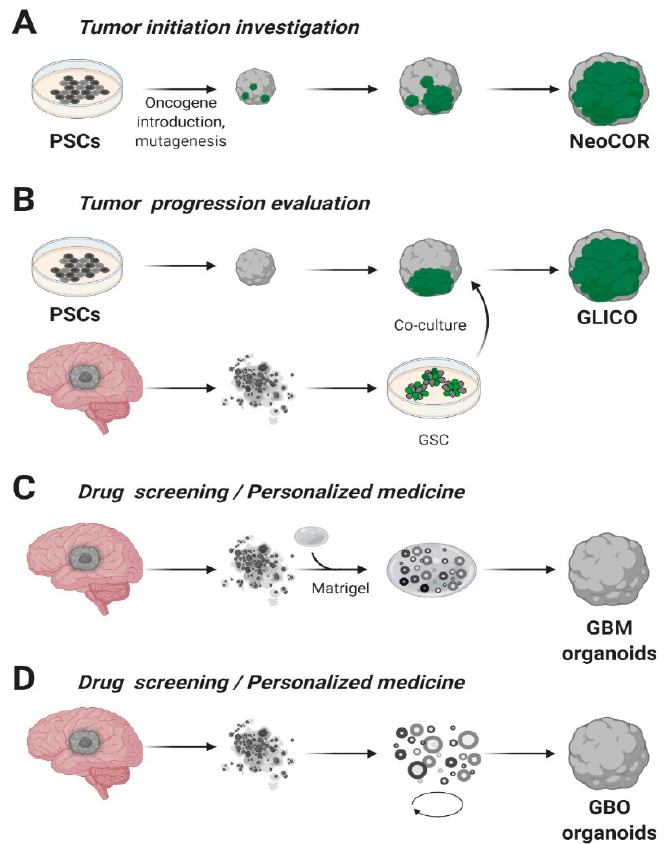
Figure 2. Glioblastoma organoids. ( A ) Cerebral organoids, derived from pluripotent stem cells (PSCs) or embryonic stem (ES) cells, can be genetically engineered introducing tumor-promoting mutations or oncogenes and green fluorescent protein (GFP) to visualize tumor growth. NeoCOR, neoplastic cerebral organoids [46,77]. ( B ) Glioblastoma stem cells (GSCs) marked with GFP have been co-cultured with cerebral organoids to obtain glioma cerebral organoids (GLICO) [77,79]. Patient-derived Glioblastoma (GBM) specimens have been embedded in Matrigel ( C ) [75] or cultured in Matrigel- and serum-free conditions, on a spinning-bioreactor ( D ) [76], to obtain GB organoids. Adapted from reference [43].